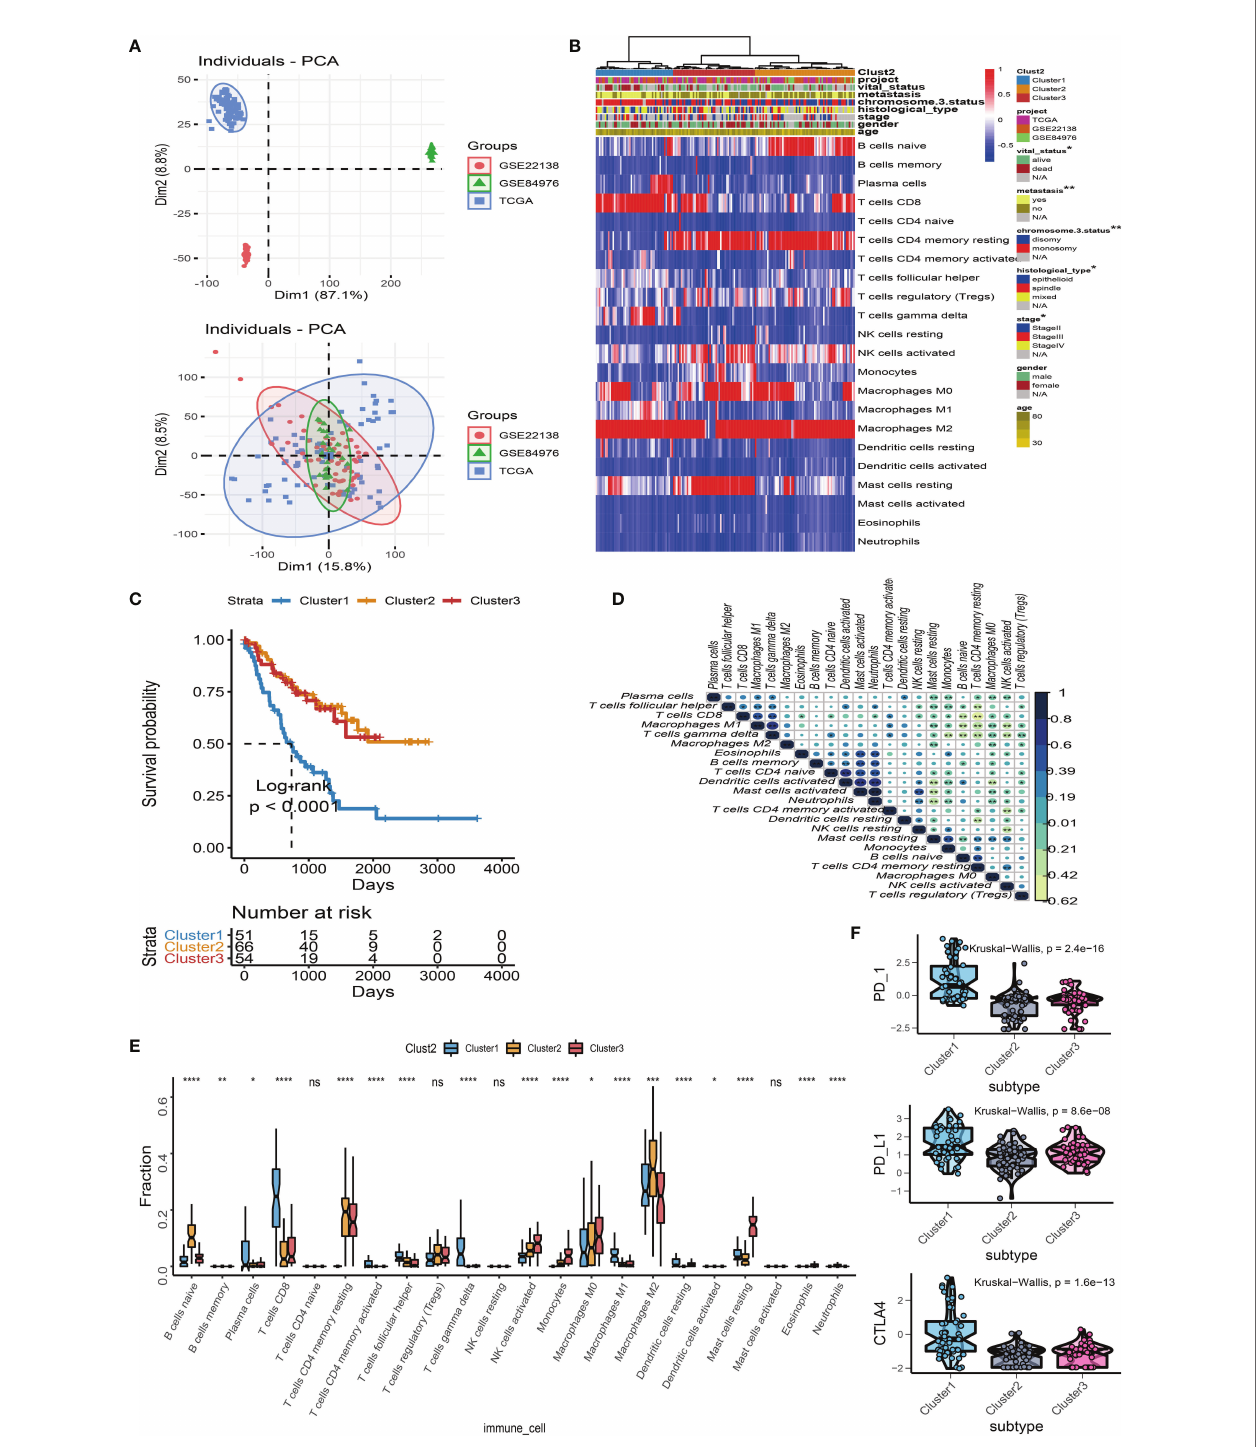
FIGURE 2 | Landscape of the in fi ltrated immune cell characterization in uveal melanoma (UM). (A) The distribution of principal component analysis for UM (TCGA- UVM, GSE84976, and GSE22138) before and after removal of batch effect. (B) Clustering of tumor-in fi ltrated immune cells in 171 UM patients using an unsupervised clustering method. Twenty-two kinds of in fi ltrated immune cells are shown by rows, and UM samples are represented by columns. (C) Kaplan – Meier plots for overall survival time of three subtypes of UM patients. (D) The correlation analysis of 22 kinds of in fi ltrated immune cells. (E) Box plots of in fi ltrated immune cells in three subtypes. (F) Box plots of immune checkpoint genes (PD-1, PD-L1, and CTLA-4) in three subtypes. * p < 0.05; ** p < 0.01; *** p < 0.001; and **** p < 0.0001. NS means “ none signi fi cance ”